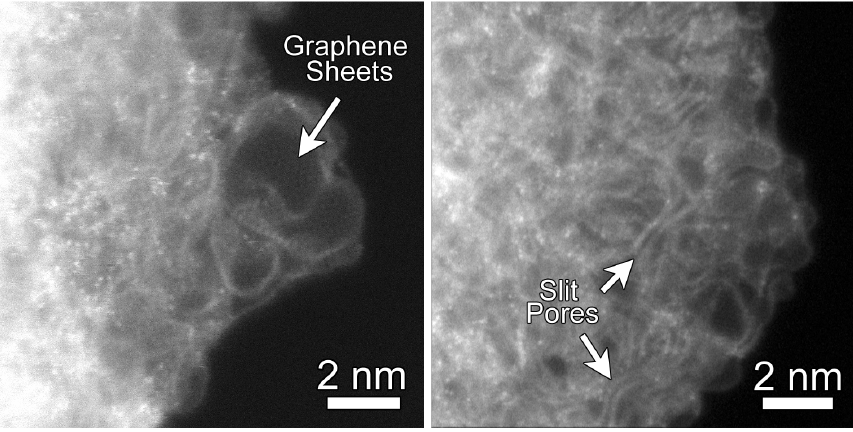
Figure 1. Representative Annular Dark-Field (ADF) Abberation-Corrected Scanning Transmission Electron Microscopy (STEM) images of carbide-derived carbons (CDCs) from experiment. CDC samples were subjected to heat treatment at 700 ◦ C for 11 h. ( Left ) regions of highly-curved graphene sheets; ( Righ t) regions where the graphene sheets form slit-like configurations. The bright atoms with the CDC structure are residual silicon atoms as confirmed through Electron Energy Loss Spectroscopy